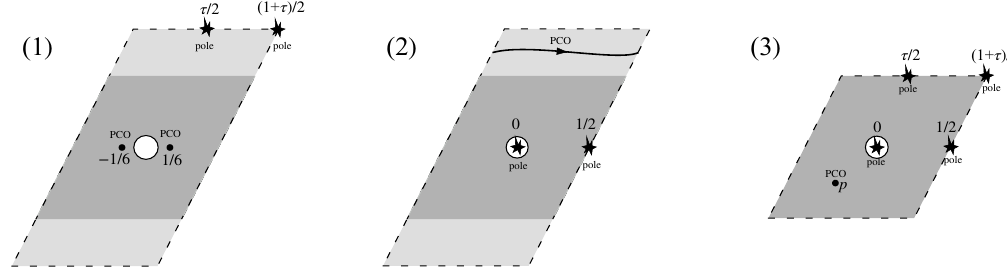
Figure 7 . PCO locations versus spurious poles for the various contributions to the tadpole ampli- tude. Case (1) represents the propagator diagram with an NS state in the loop, case (2) represents the propagator diagram with a Ramond state in the loop, and case (3) represents the fundamental tadpole